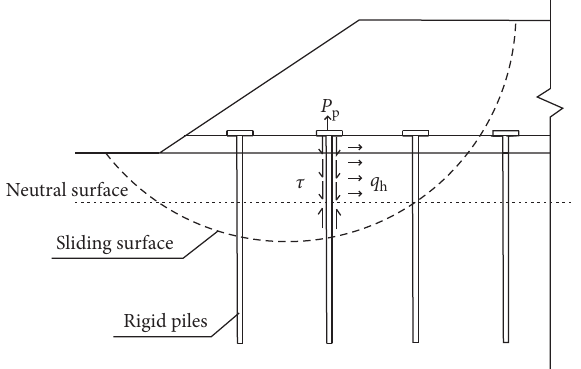
Figure 5: Forces exerted by pipe piles on sliding